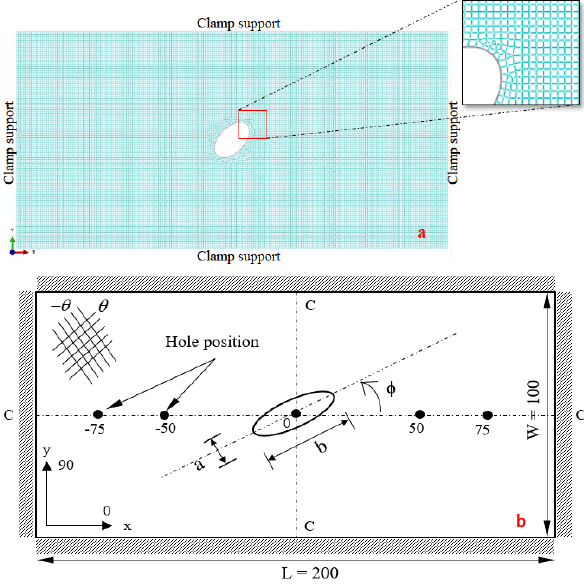
Figure 3: (a) Meshing of the plate with elliptical hole and (b) geomet- ric